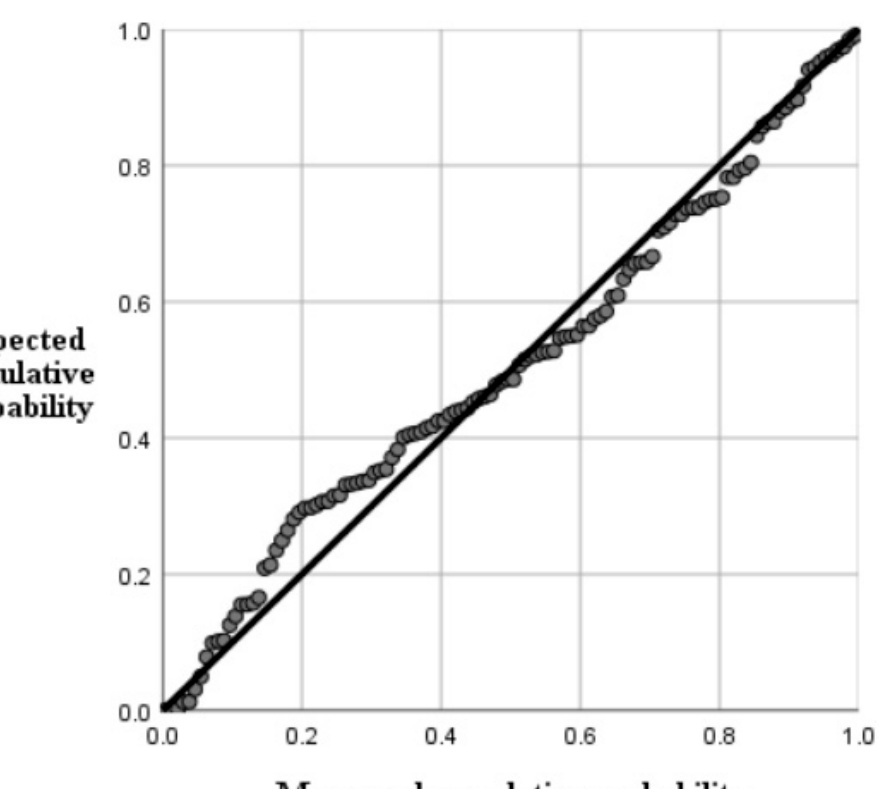
Figure 7. Normal P-P plots of regression normalized residuals.